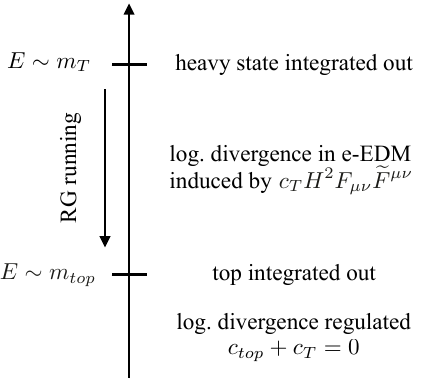
Figure 3 . Schematic cartoon explaining the generation of an electron EDM as a two-loop running e(cid:11)ect due to the top